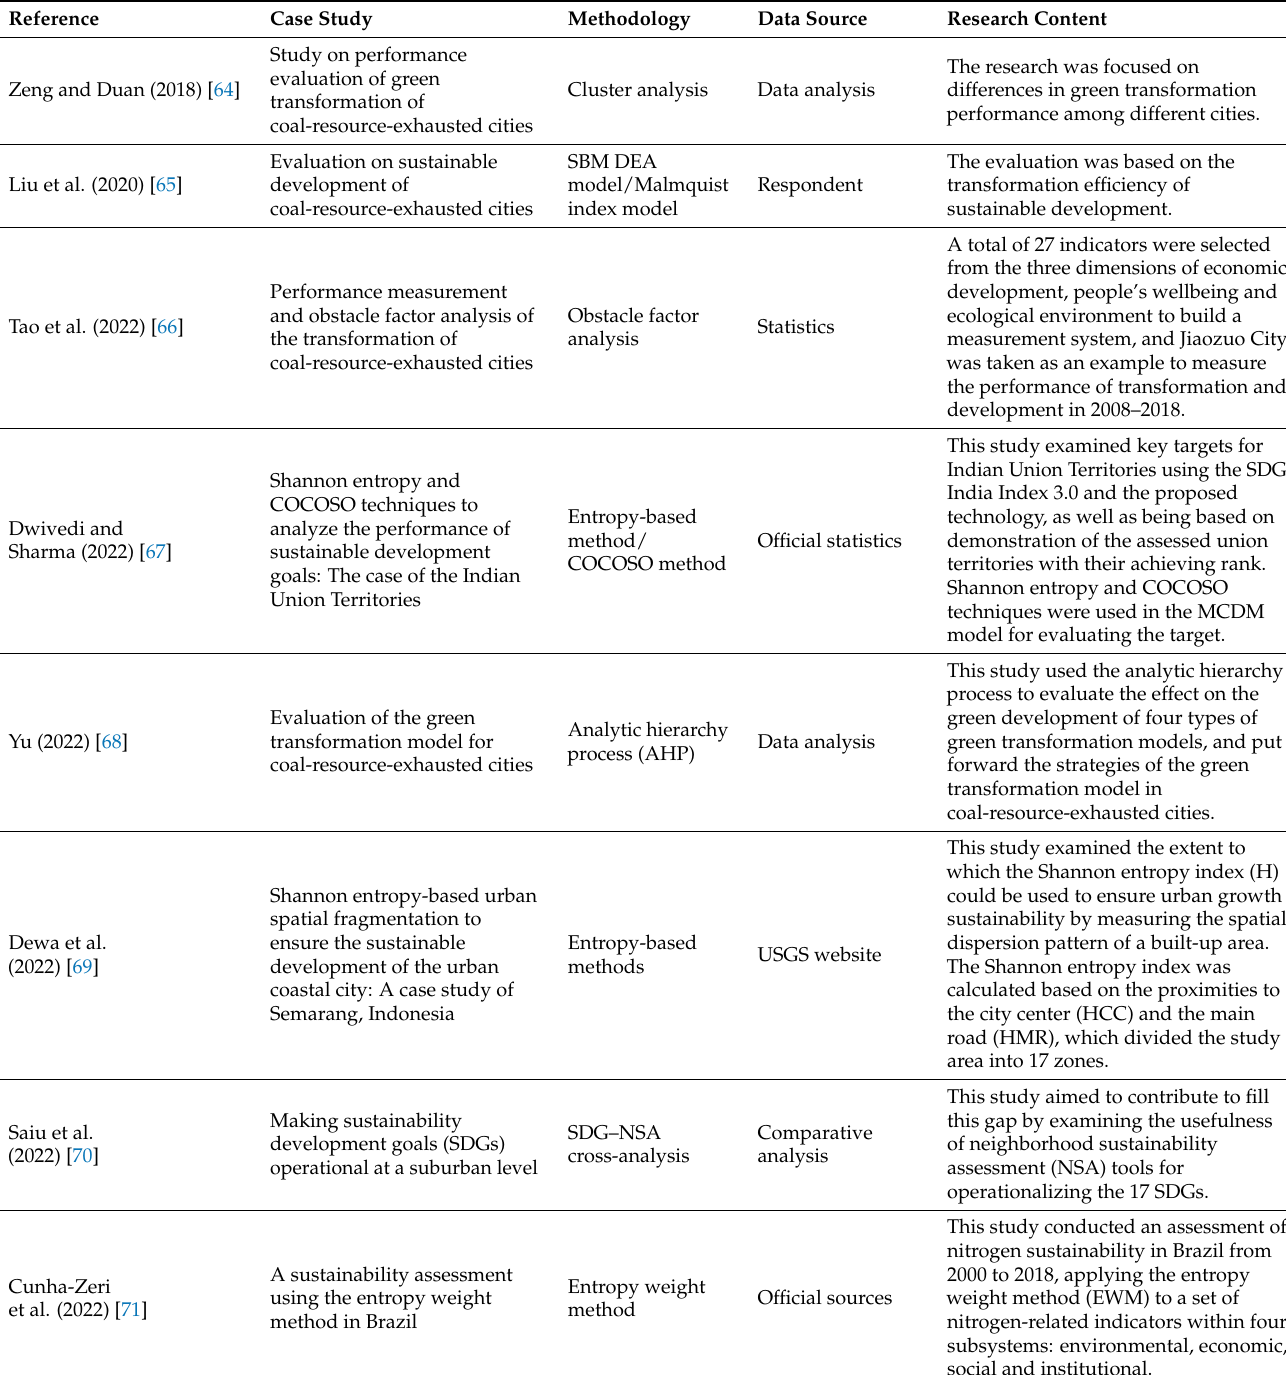
Table 3. Comparison of relative research methods and